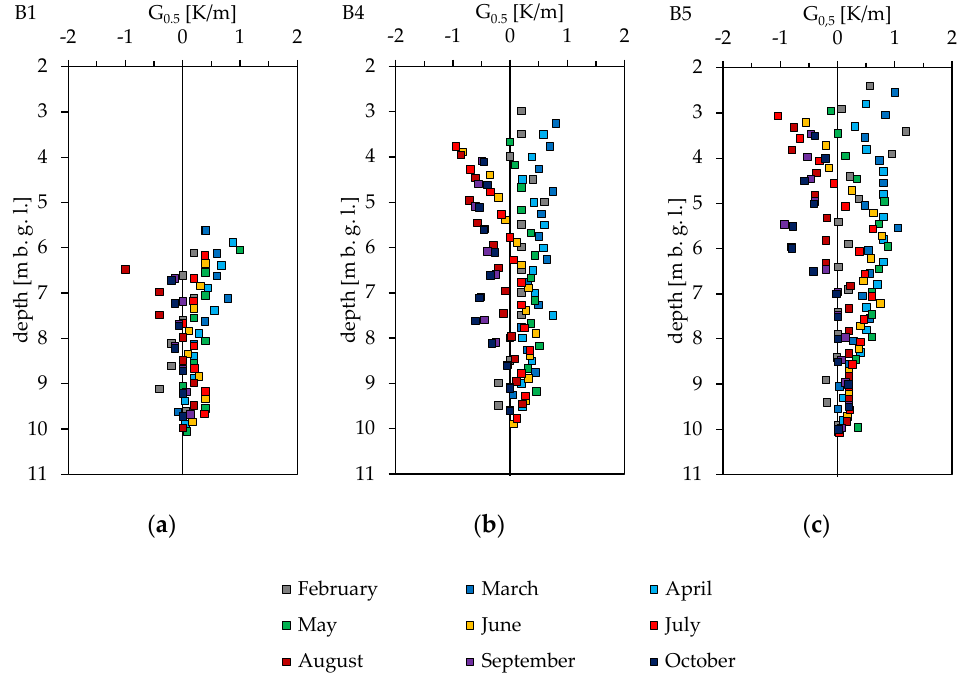
Figure 6. Thermal gradients (G 0.5 ) between each measuring step of 0.5 m for selected boreholes; ( a ) B1; ( b ) B4; ( c ) B6.